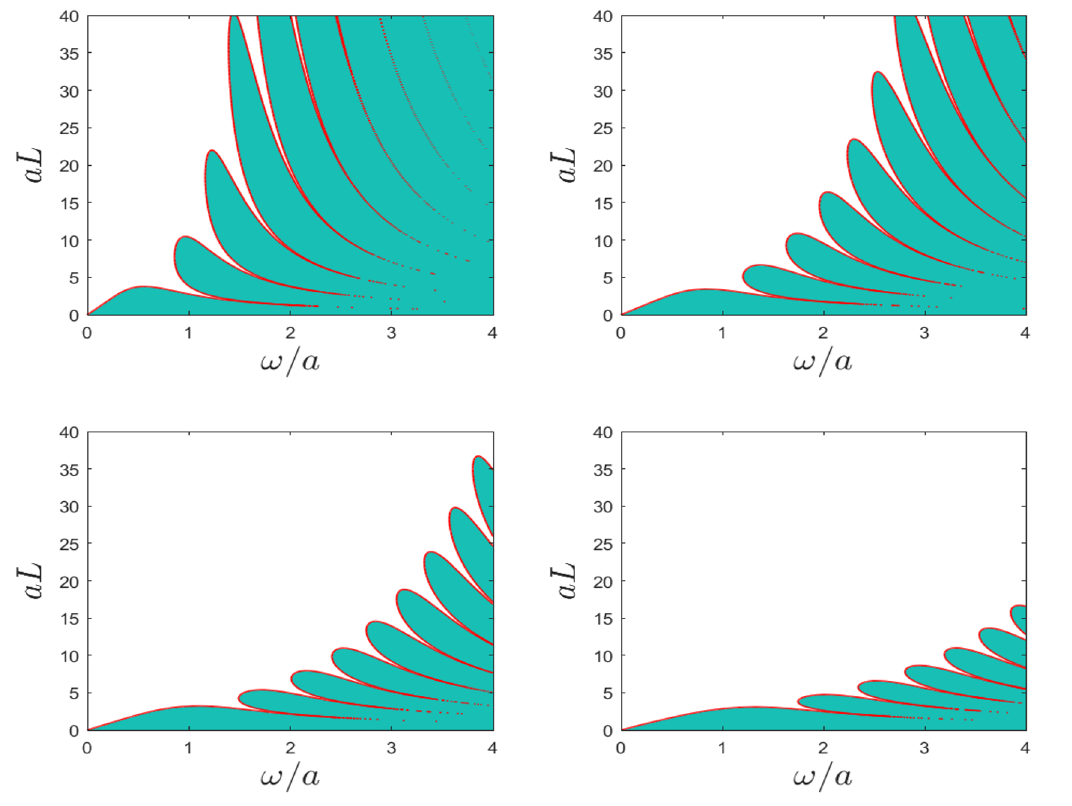
Figure 5 . Entanglement region in the ω − L plane. The four subfigures stand for D = 3 , D = 4 , D = 5 , D = 6 respectively from left to right and top to